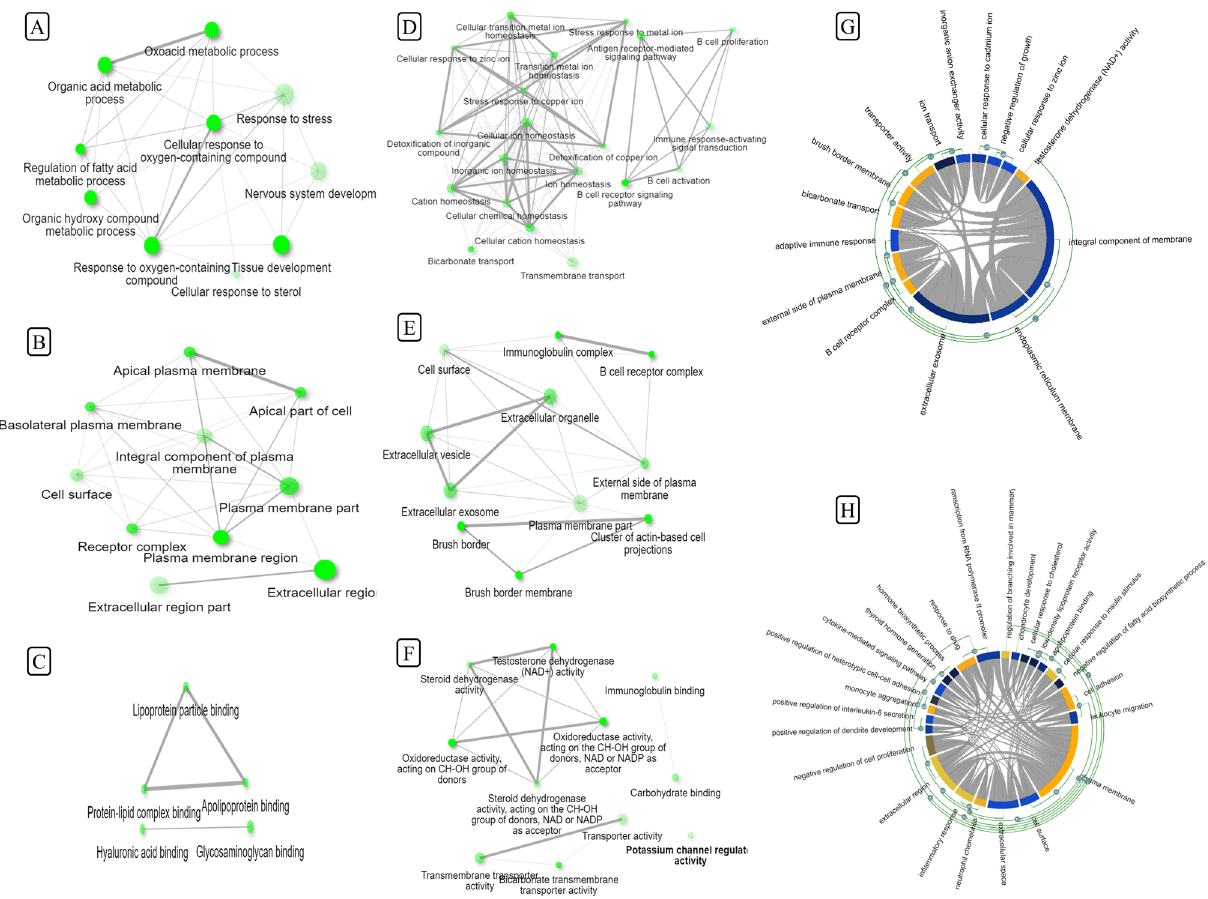
Figure 3. Functional characteristic analysis of DEGs on Shinny GO v0.61 (http:// bioin forma tics. sdsta te. edu/ go/). ( A – C ) represents the gene ontology enrichment for upregulated DEGs and ( D – F ) represents the gene ontology for down regulated DEGs. ( A ) and ( D ) networks are DEGs for biological process (BP), ( B ) and ( E ) are cellular components (CC) and ( D ) & ( F ) networks are for molecular function (MF) gene enrichment analysis. cumulative biological processes for upregulated and downregulated DEGs,